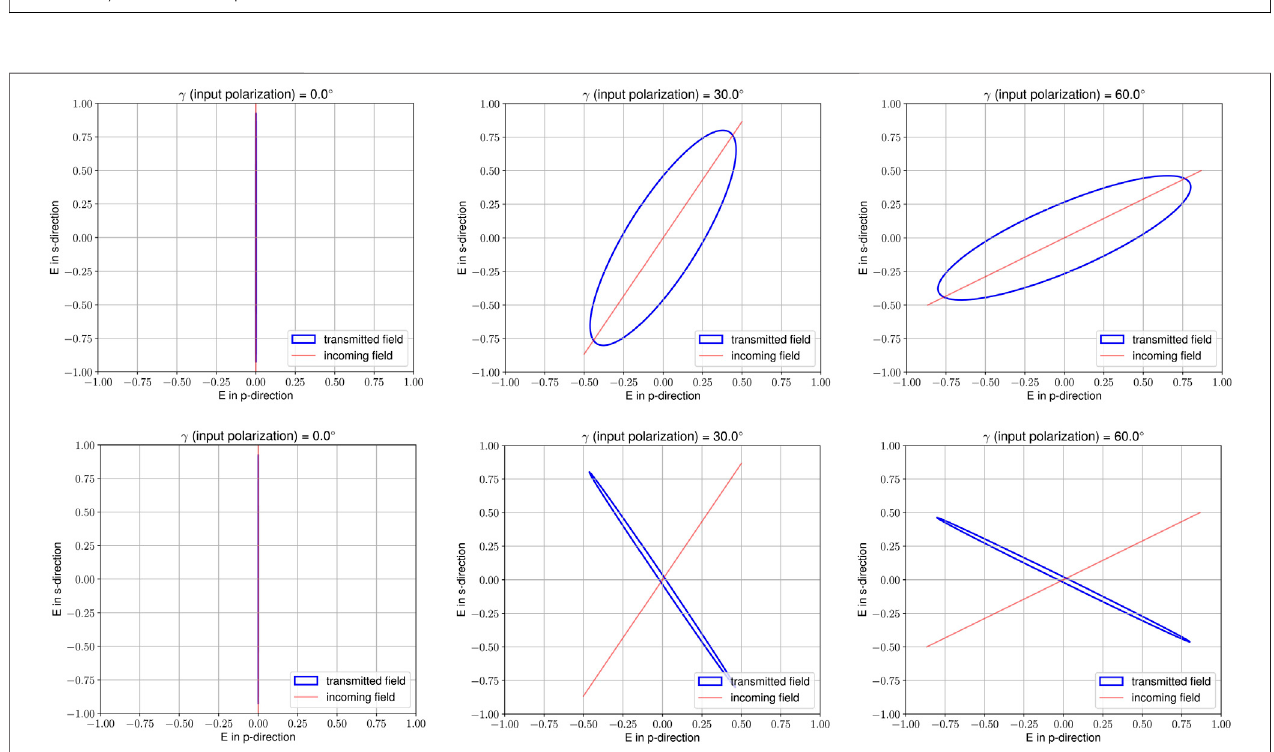
FIGURE4| Effectofbirefringenceinathicksapphiresubstrateforabeamenteringitwith1 ° inclinationandvaryinginputpolarization( γ =0 ° ,30 ° ,60 ° ).Inthetoprow, the effect for Δ n = 0 is given while the bottom row shows the effect for Δ n = 2.8 · 10 – 6 (refer to Eq. 9 ).